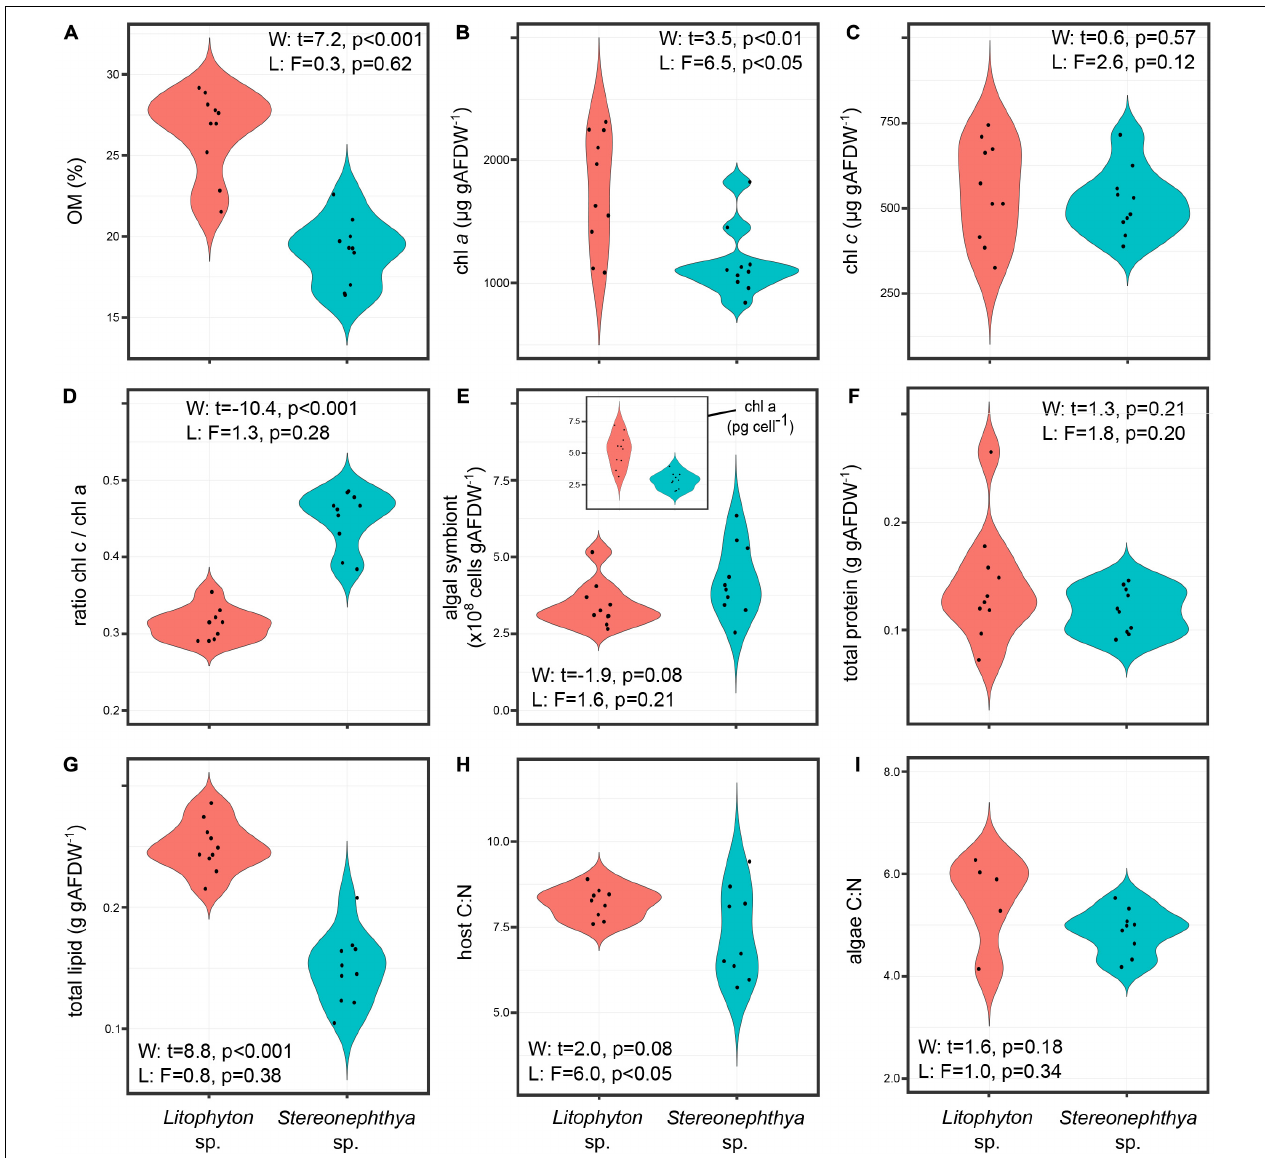
FIGURE 2 | Comparison of the distribution in individual trait values for the two study species: (A) OM, (B) chl a , (C) chl c, (D) ratio chl c /chl a , (E) algal symbiont content – inset content of chl a by algal symbiont cell, (F) total protein, (G) total lipid, (H) host C:N; (I) algae C:N.